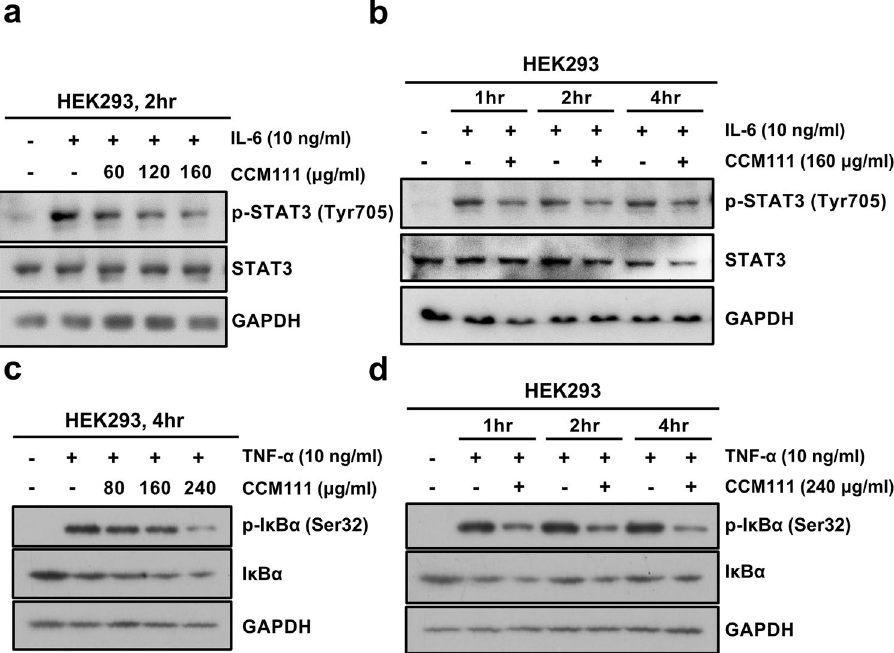
Figure 3. The effects of CCM111 on the STAT3 signaling transduction pathway in HEK293 cells. ( a – d ) Total cell lysates were prepared for Western blot analysis to detect the protein levels. ( a ) The cells were treated with h-IL-6 (10 ng/ml) and CCM111 (0, 60, 120 or 160 μ g/ml) for 2 hours. ( b ) The cells were treated with h-IL-6 (10 ng/ml) alone or in combination with CCM111 (160 μ g/ml) for 1, 2 and 4 hours. ( c ) The cells were treated with TNF- α (10 ng/ml) and CCM111 (0, 80, 160 or 240 μ g/ml) for 2 hours. ( d ) The cells were treated with TNF- α (10 ng/ml) alone and/or in combination with CCM111 (240 μ g/ml) for 1, 2 and 4 hours. ( a , b ) The protein levels of STAT3 and phospho-STAT3 were detected. ( c , d ) The protein levels of I κ B α and phospho-I κ B α were detected. GAPDH served as an internal control. The full length blots images are presented in Supplementary Fig. 2. Results were obtained from three independent